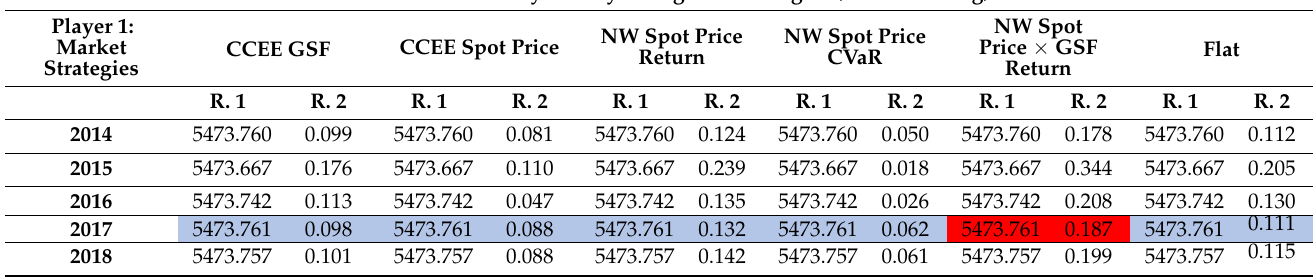
Table 3. Payoff matrix [millions of BRL] (the proposed methodology was applied by Leonel [27], where similar results were